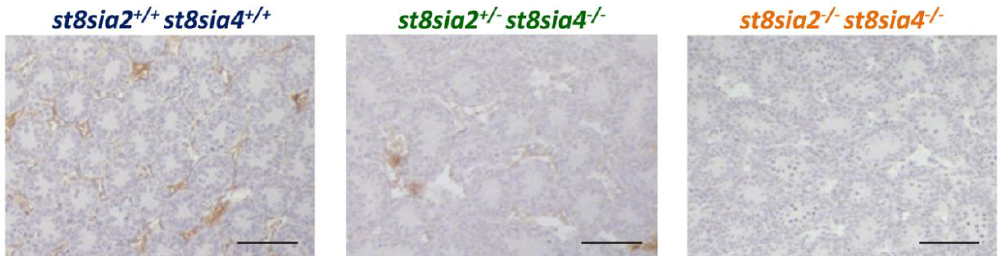
Figure 2. Visualization of polySia in postnatal day 9.5 testis of knockout and wild-type mice. For the immunohistochemical localization of polySia tissue sections were treated with a mAb against polySia. All scale bars: 100 μm.